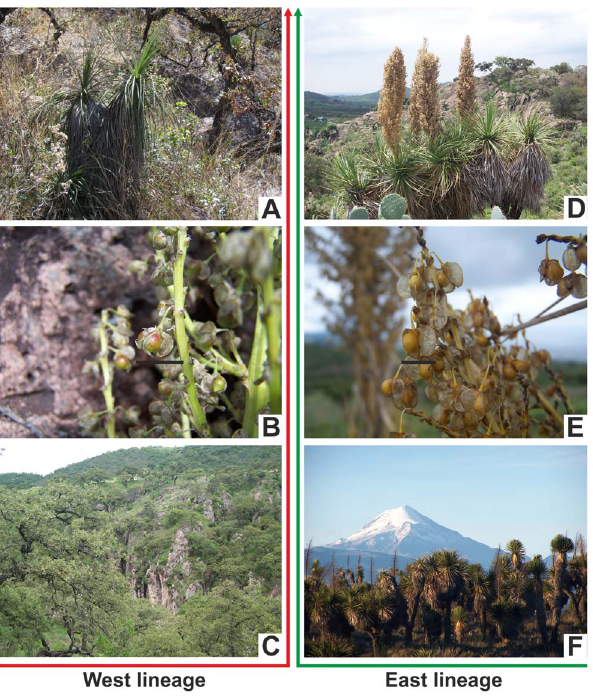
Figure 5. A-C west lineage. A. Plant showing two branches. B. Primary inflorescence branch, showing fruits and seed, scale bar = 1 cm. C. Panoramic image of the oak forest type in the locality of Rı´o Los Patitos, Zacatecas, Mexico. D-F east lineage. D. Plant showing seven branches and inflorescences. E. Primary inflorescence branch, showing fruits and seeds, scale bar =1 cm. F. Panoramic image of xerophytic scrub habitat type with Pico de Orizaba in the background, Veracruz, Mexico. Photos by E. Ruiz-Sanchez.